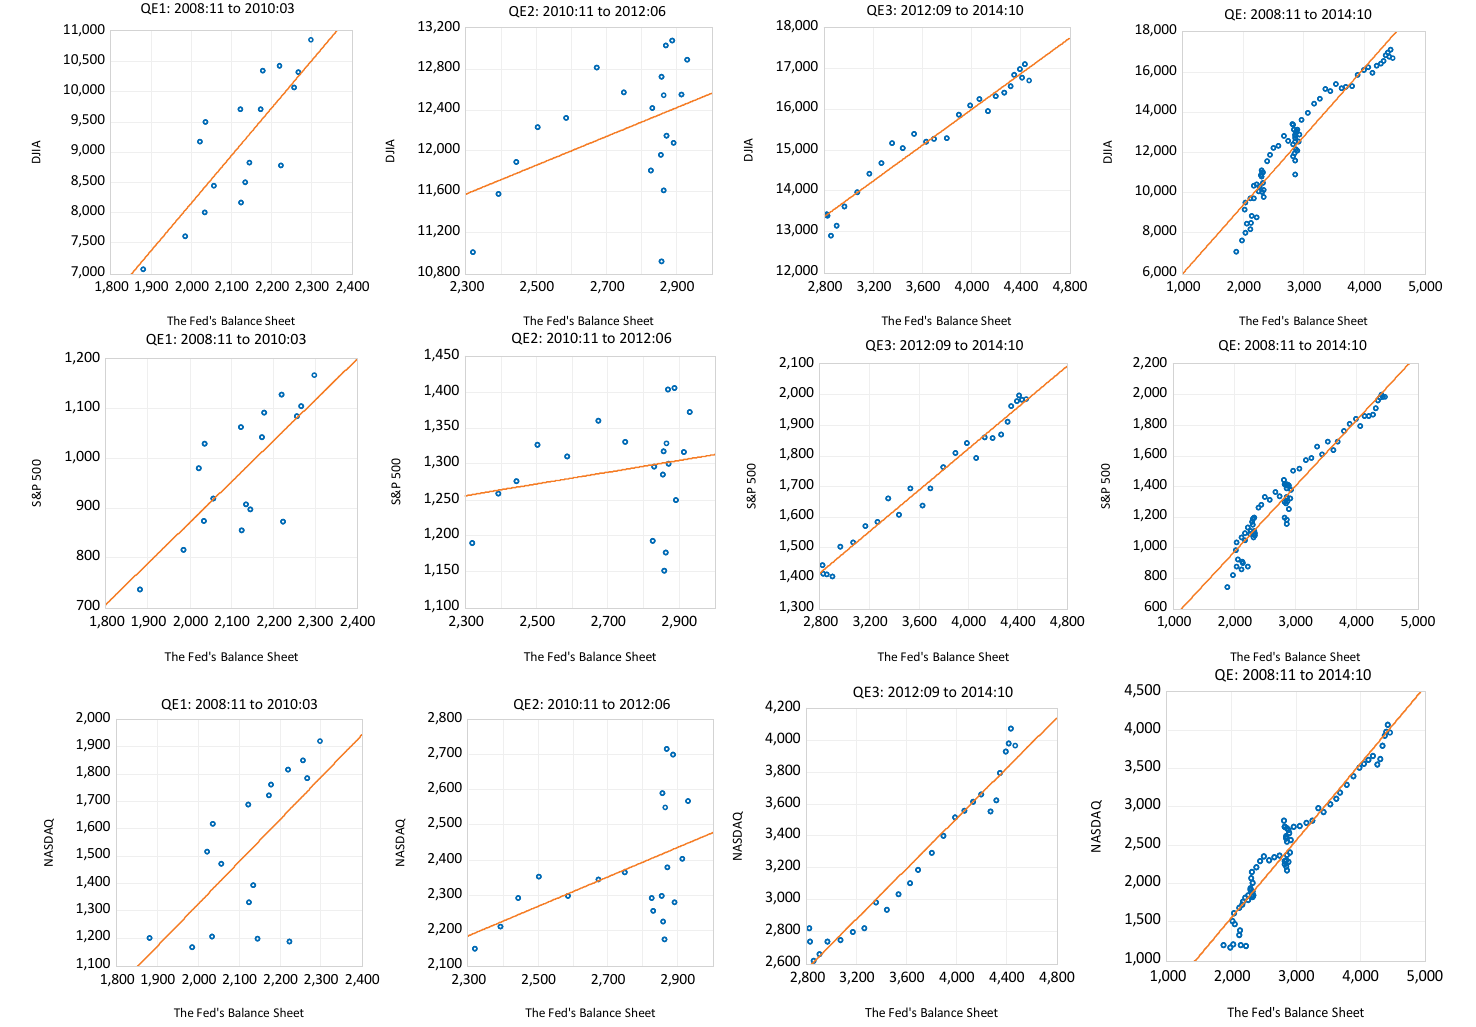
Figure 1. Scatter plot of stock prices against the Federal Reserve’s balance sheet (in billions).